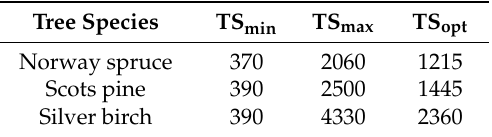
Table 1. Temperature sum (TS, d.d.) limits (TS max , TS min ) and the temperature sum for maximum growth (TS opt ) of different tree species